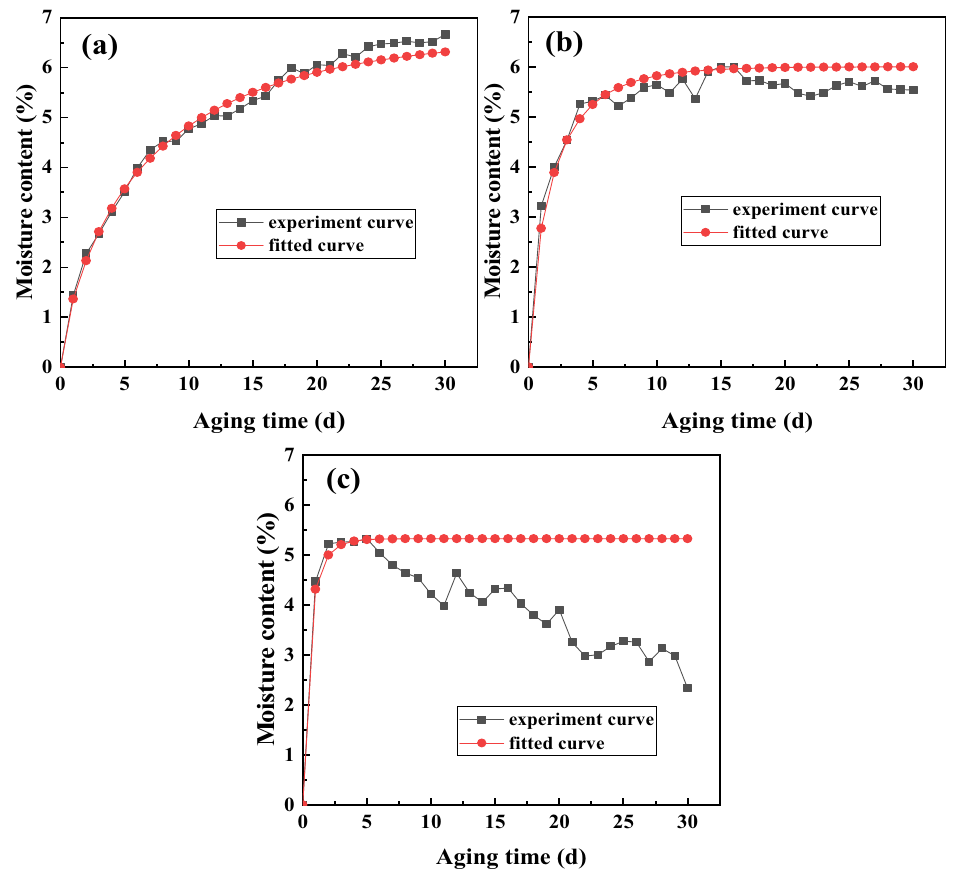
Figure 4: Moisture absorption ratio versus aging time curves based on experimental results and numerical analysis: ( a ) 25°C, ( b ) 55°C, and ( c )